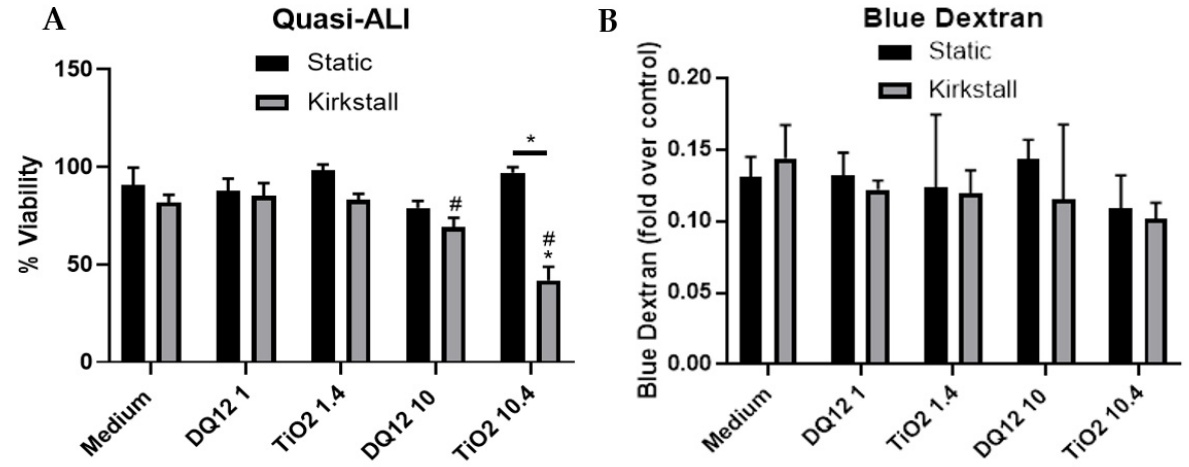
Figure 3. Viability and membrane integrity, 24 h post quasi-ALI exposure of both DQ 12 and TiO 2 on A549 + dTHP-1 co-cultures. Cells were exposed for 24 h at an ALI using the quasi-ALI method and incubated in either static or fluid flow conditions, before analysing cytotoxicity ( A ) and membrane integrity (blue dextran ( B )). N = 3 for fluid flow and N = 5 for static with all assays performed in triplicate. The data is presented as the mean ± standard deviation. Significance is denoted as the following: compared to the medium control p < 0.01 (*); compared to the lower concentration p < 0.01(#); line is comparing the two systems p < 0.01 (*).